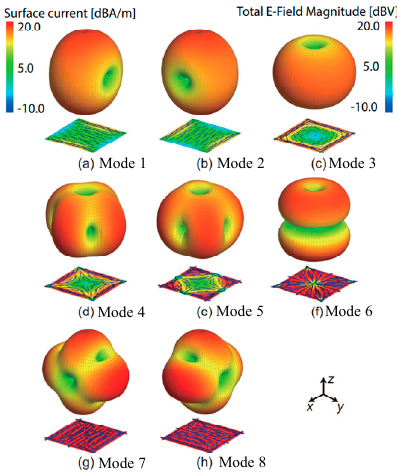
Figure 14. Radiation patterns of seven characteristic modes of a patch antenna in [87].